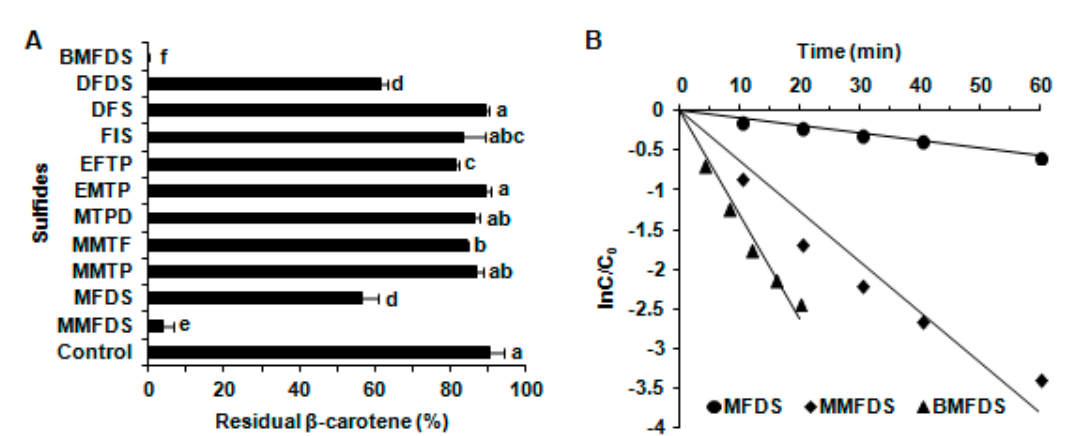
Figure 1. The effect of oxygen-containing sulfides on the degradation of β -carotene in ethanol under UVA irradiation. β -Carotene was treated with various oxygen-containing sulfur flavor molecules under UVA irradiation for 60 min ( A ) or within 60 min ( B ) in ethanol system. The residual β - carotene ( A ) and the first-order kinetics curve of β -carotene degradation ( B ) were determined. The bar results are expressed as means ± SD from three independent replicates. Different small letters show significant differences ( p <